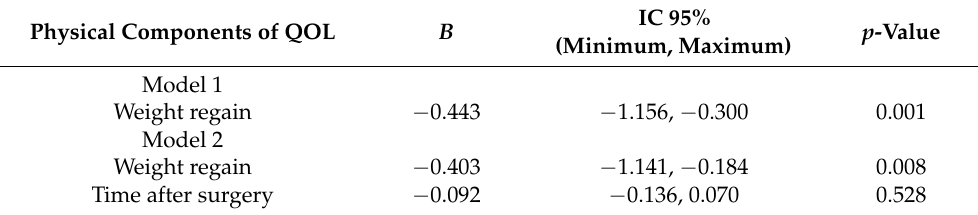
Table 5. Correlation between QOL and weight regain in women with more than 24 months after